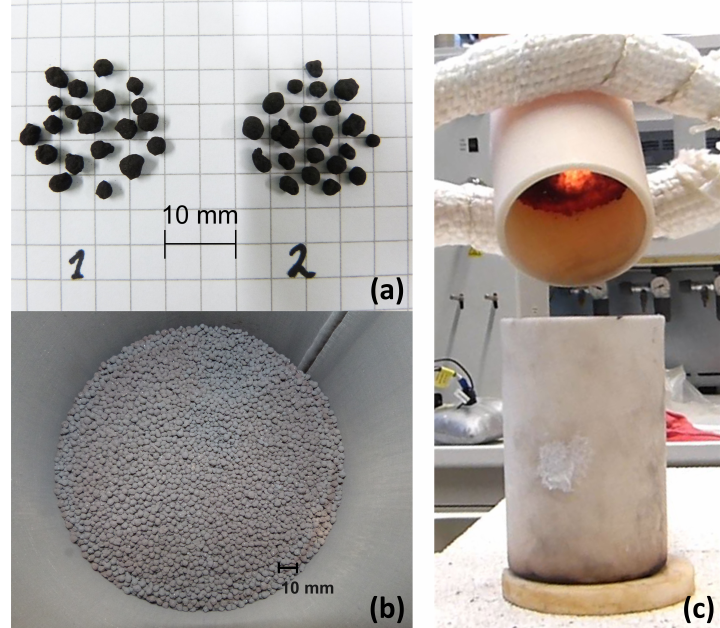
Figure 9. ( a ) Comparison of fresh manganese–iron oxide particles (1) to manganese–iron oxide particles after 15 redox cycles in the moving bed reactor (2). ( b ) Picture of the uppermost bulk layer after the described moving bed experiment. ( c ) Picture of the flowability tests performed after the